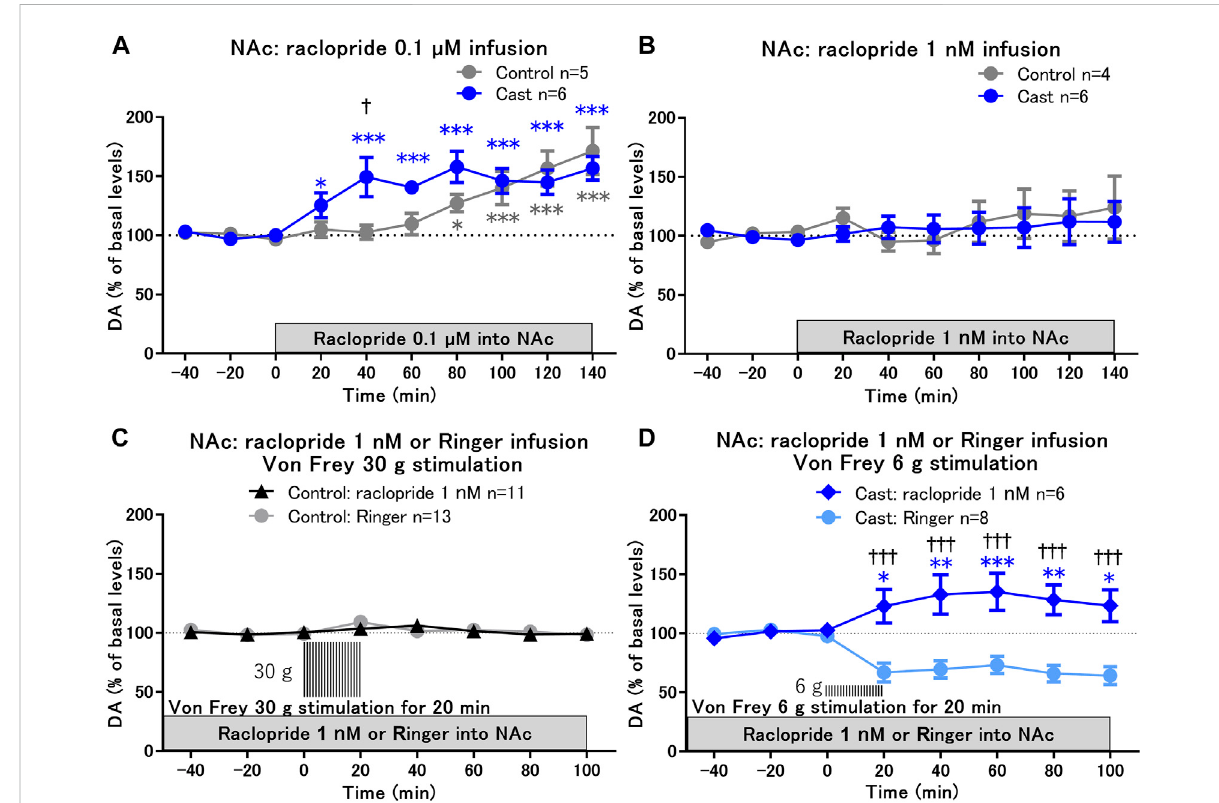
FIGURE 2 EffectsoflocalinfusionofracloprideonvonFreystimulation-inducedchangesindopamine(DA)levelsinthenucleusaccumbensshell(NAcSh) of rats with cast immobilization. (A,B) Effects of local infusion of a D2-like receptor antagonist, raclopride, into the NAcSh at 0.1 μ M (A) and 1 nM (B) on thebasal levelsofDA; * p < 0.05, *** p < 0.001 versus thebasal levels ofDA in thesame group; mixed linear models; † p < 0.05 betweenthecontrol and cast groups; two-way ANOVA and Sidak ’ s multiple comparisons test. (C,D) Von Frey fi lament stimulation-induced changes of DA in the NAcSh after 2 h of local infusion of raclopride at a low dose (1 nM) in the control (C) and cast (D) groups. DA levels for the fi rst 80 min of raclopride infusion are not included, because raclopride infusion at 1 nM did not affect DA levels for 120 min as shown in (B) . Results of von Frey fi lament stimulation with Ringer infusion in the control (C) and cast (D) groups were reproduced from Figures 1E,F, respectively. * p < 0.05, ** p < 0.01, *** p < 0.001versusthebasallevelsofDAinthesamegroup;mixedlinearmodels; ††† p < 0.001betweengroupswithRingerandracloprideinfusion;two-way ANOVA and Sidak ’ s multiple comparisons test; Data represent mean ± SEM. The number of rats is indicated in the